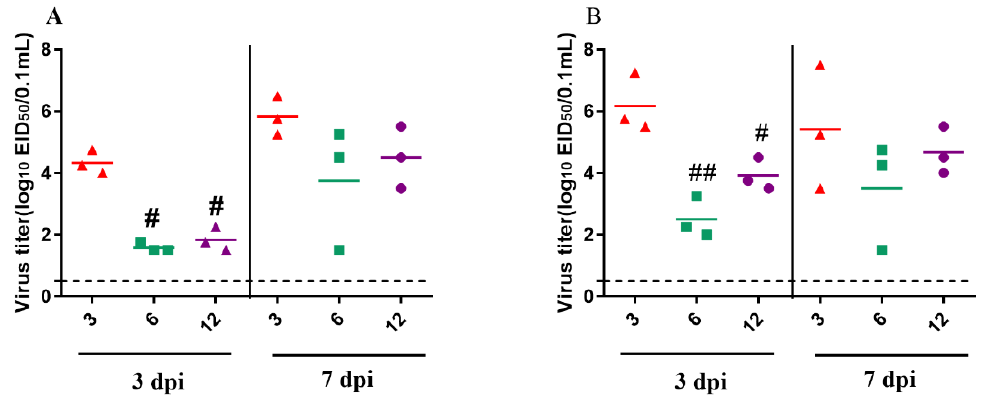
Figure 7. Virus titers in tissues of 3-, 6-, and 12-week-old pigeons inoculated with the GZ08 virus at 3 and 7 DPI in ( A ) brains and ( B ) lungs. Data are presented as means ± standard deviation (SD). The dashed black line denotes the lower limit of detection. Statistical analysis was performed using GraphPad Prism version 8.0.1. Differences in virus titers in 3-, 6-, and 12-week-old pigeons were compared by one-way ANOVA. Compared to the 3-week-old pigeon group, # P < 0.05 and ## P < 0.01 were considered to indicate statistically significant differences, unless stated otherwise.